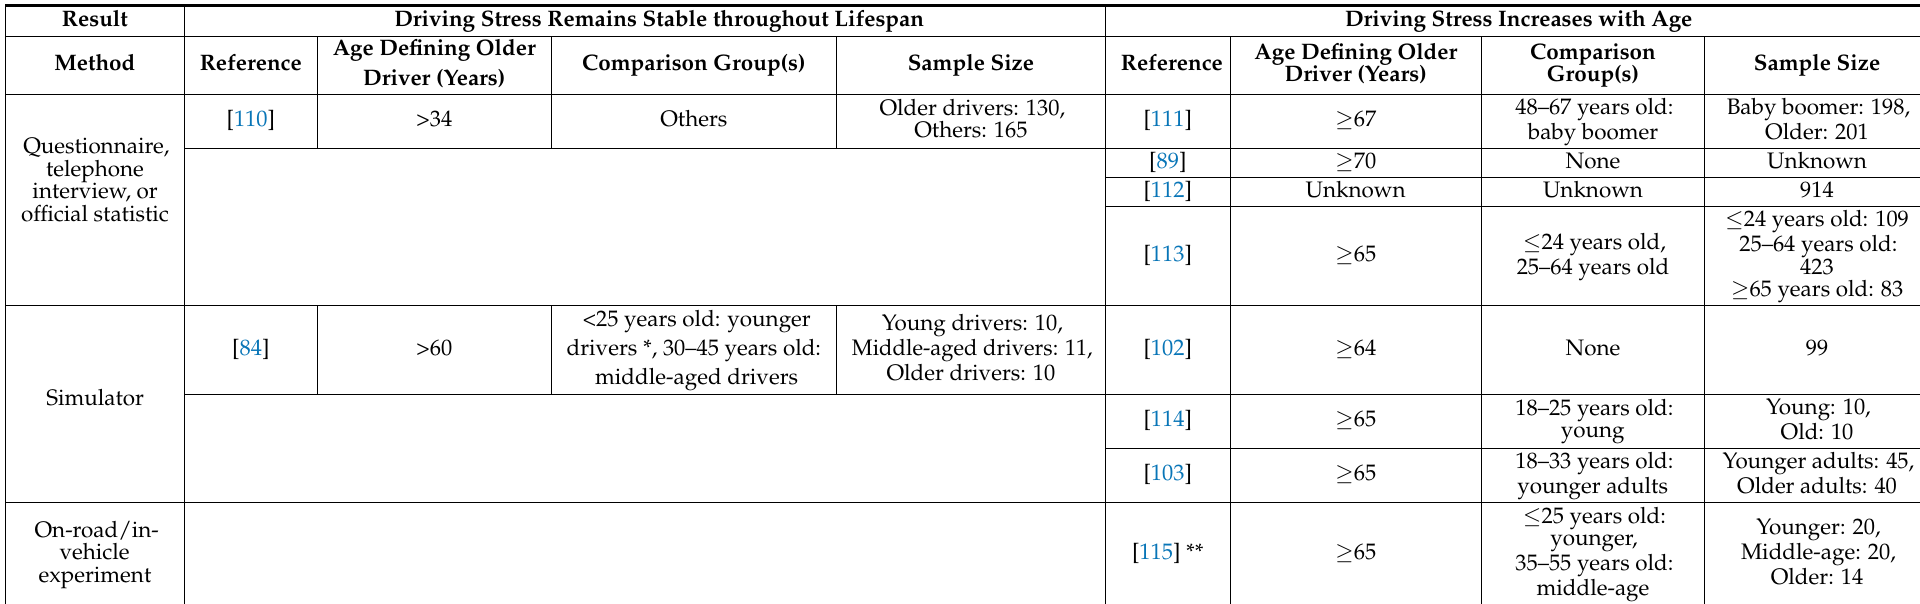
Table 5. Methods and results from studies on older drivers’